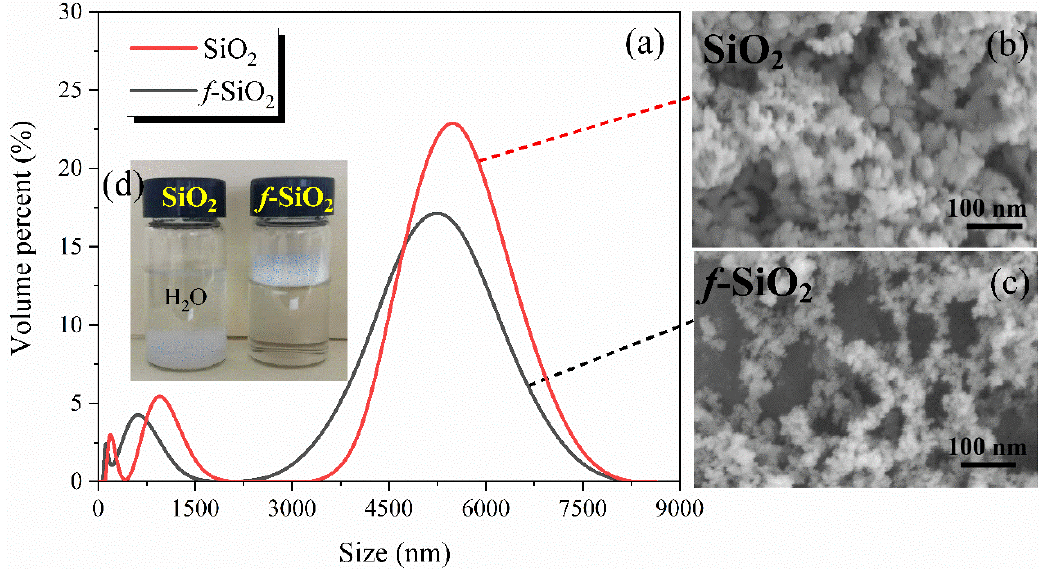
Figure 3. ( a ) Particle size distribution; ( b , c ) SEM images of SiO 2 before and after modification; ( d ) hydrophobicity of SiO 2 and f -SiO 2 . Table 1. The effect of TMDVS content on the BET surface area of f -SiO 2 . Mass Fraction of TMDVS Relative to SiO 2 BET Surface Area (m 2 /g)